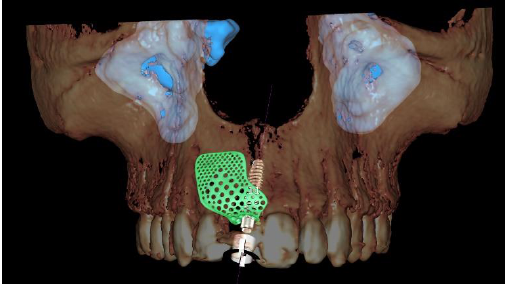
Figure 3. Computer-aided design (CAD) of the customized titanium mesh based on the contralateral maxillary outline and OssBuilder (Osstem Implant Co., Ltd., Seoul, Korea) features.